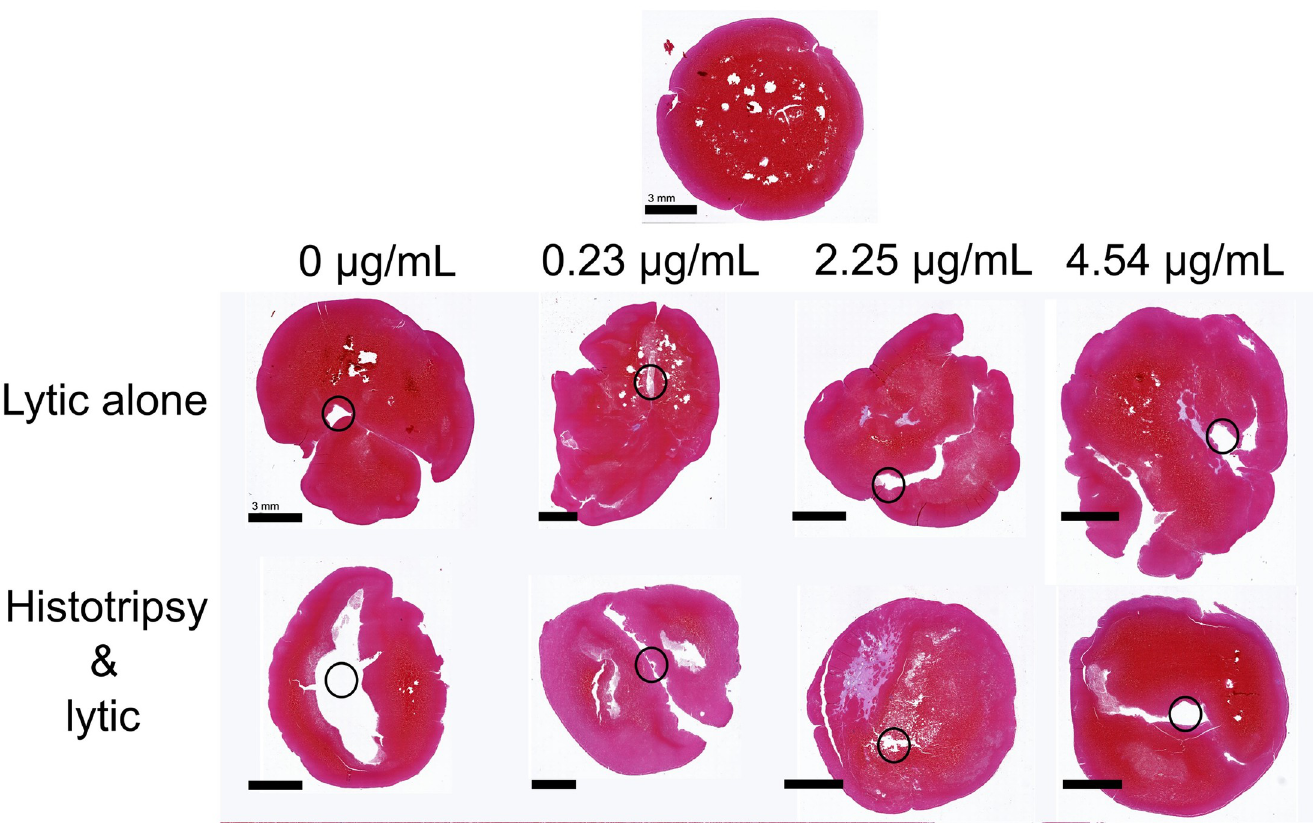
Fig 7. Representative clots for each rt-PA dose explored for the single-path histotripsy treatment arms. The scale bar corresponds to a 3 mm distance. The top image represents a control sample (no histotripsy, no lytic, and no catheter). The gaps within this control clot are histological artifacts. The concentration of rt-PA infused is noted at the top of each column for the bottom two rows (sections for samples treated with lytic and histotripsy). Black circles depict the approximate location of the catheter.